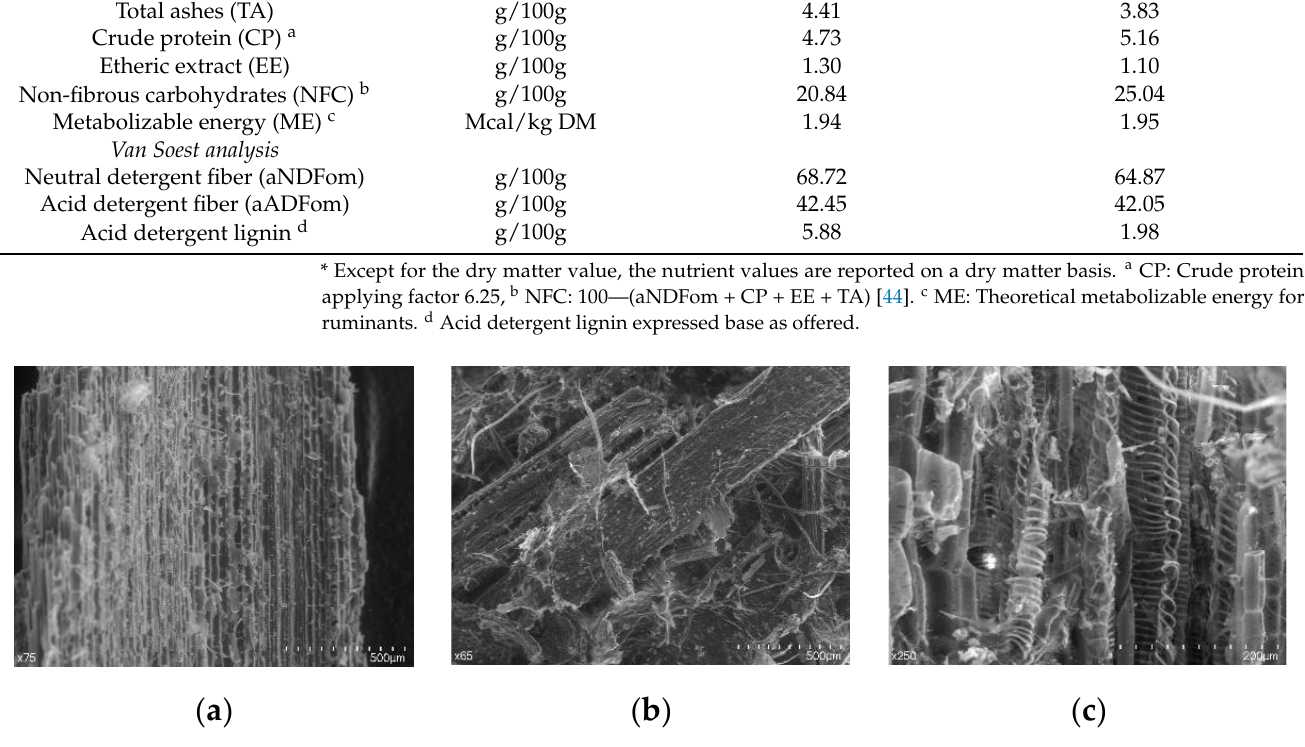
Figure 6. Electron microscopic structural analysis of ryegrass fescue hay before and after SSF with P. ostreatus for 14 days, ( a ) vegetal material before SSF; ( b , c ) vegetal material after SSF, × 65 and × 250. The total protein evaluation in submerged fermentation had a value of 0.02 ± 0.005 g/L. The enzymatic activities expressed in U/L were 4.38 ± 0.35, 9.39 ± 5.14, and 10.60 ± 5.71 for MnP, LiP and Lac, respectively, while expressed as specific enzymatic activity (U/g PT), for the same enzymes it was 175.48 ± 19.94, 380.05 ± 140.49 and 477.98 ± 334.24, respectively.